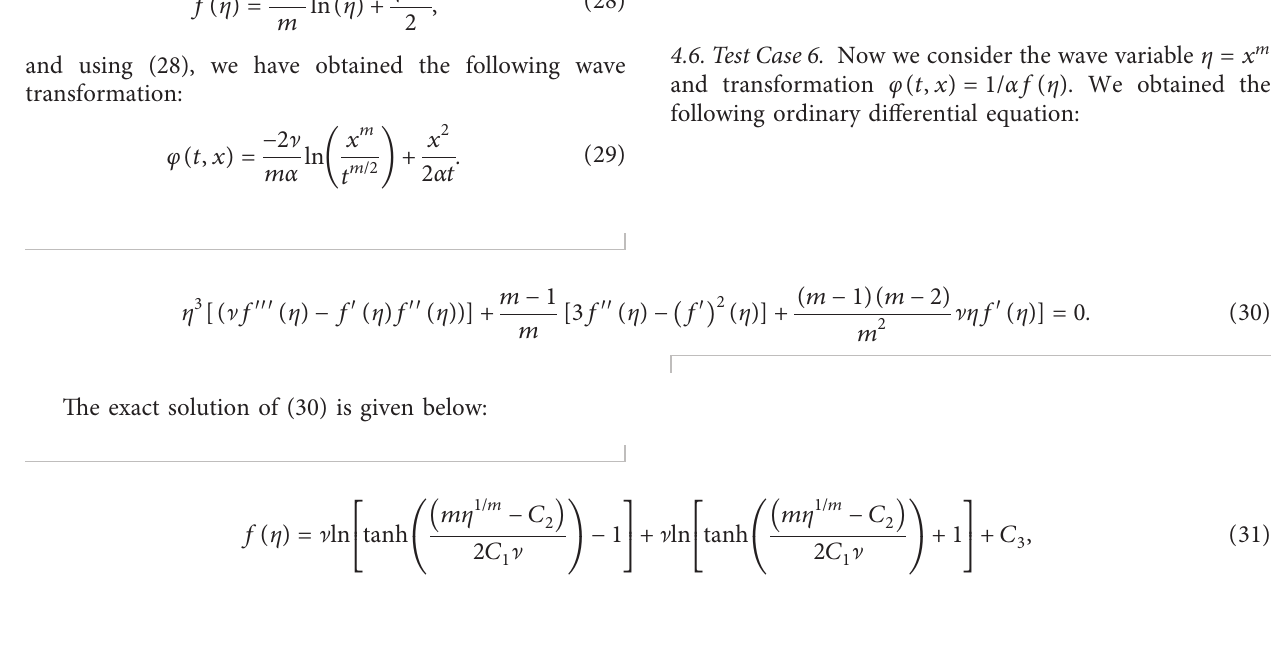
given in (20) for α � 10 and ] � 1 , 2 , 2 . 5 , 3